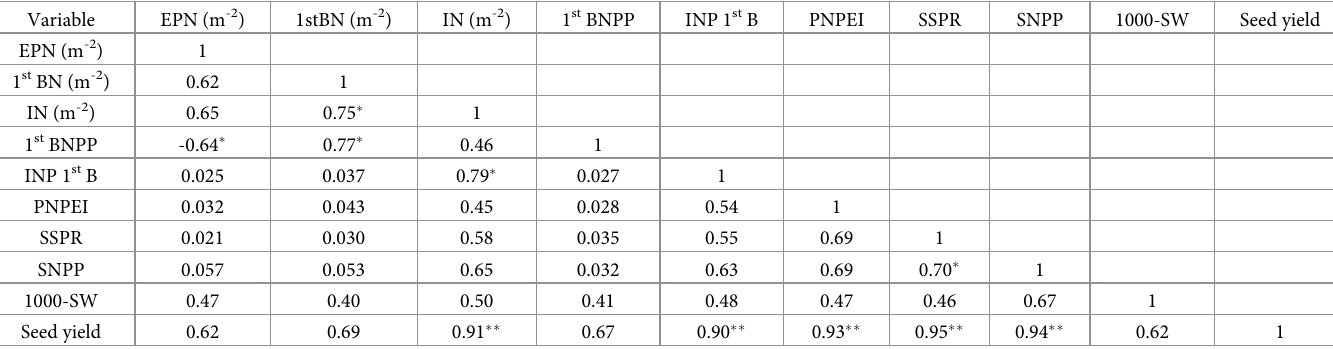
Table 1. Relevant analysis of seed yield and seed-setting factors under spraying treatments (experiments 1 and